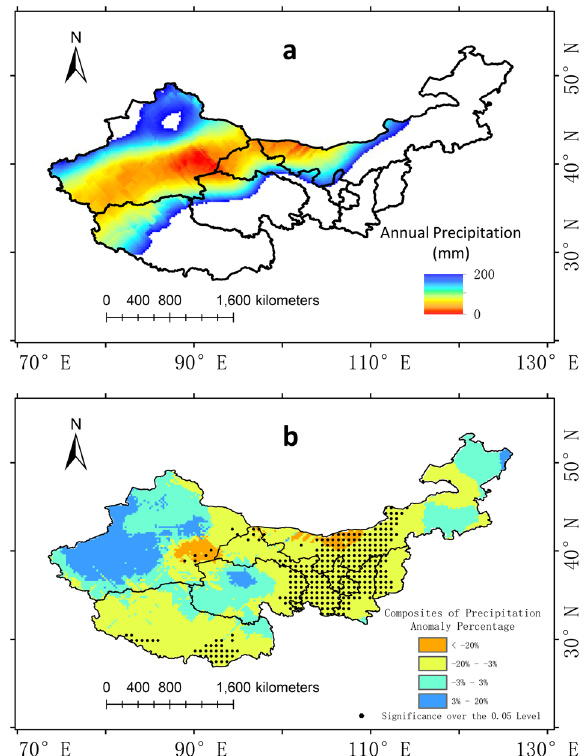
Figure 7. ( a ) The distribution of China’s arid region in El Niño years and ( b ) the composite annual precipitation anomaly percentage. The dotting represents the 0.05 significance level. The maps are generated with Arc Map version 10.5 (http:// www. esri. com/ sofwa re/ arcgis).